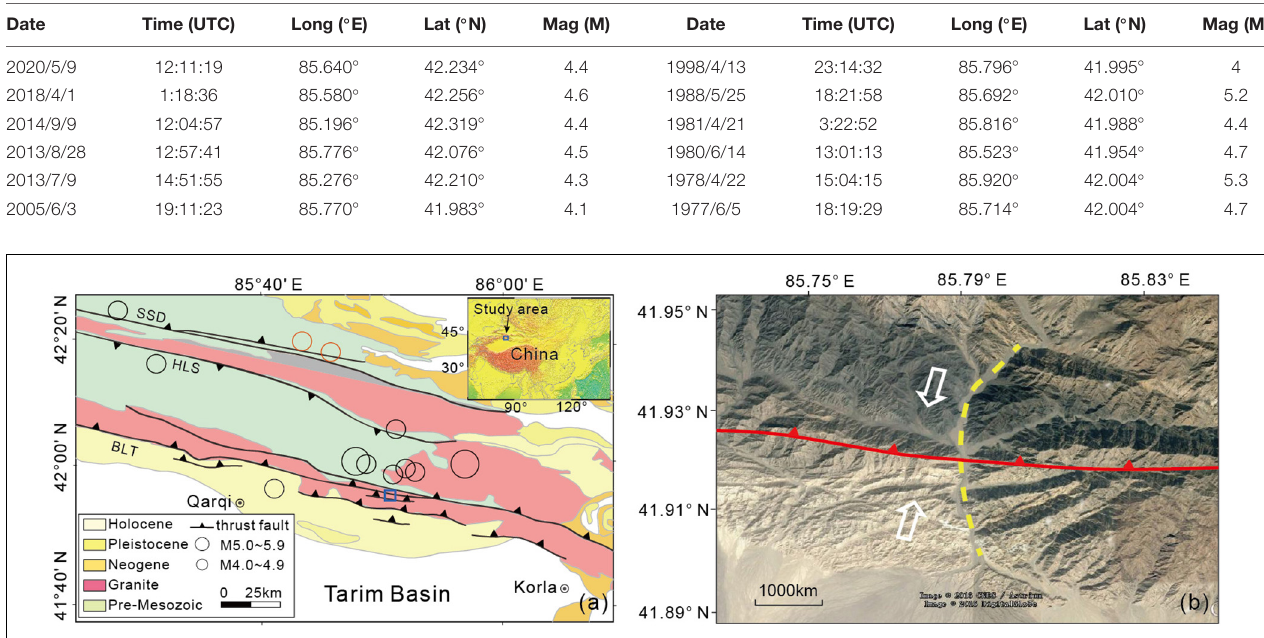
FIGURE 1 | Geologic structure map and seismic distribution of Tiemenguan section of BLT fault (a) , spatial distribution of soil gas survey lines (b) . The red circles indicate the earthquake that occurred after the measurement. SSD, Songshudaban fault; HLS, Huolashan fault; BLT, Beiluntai fault.